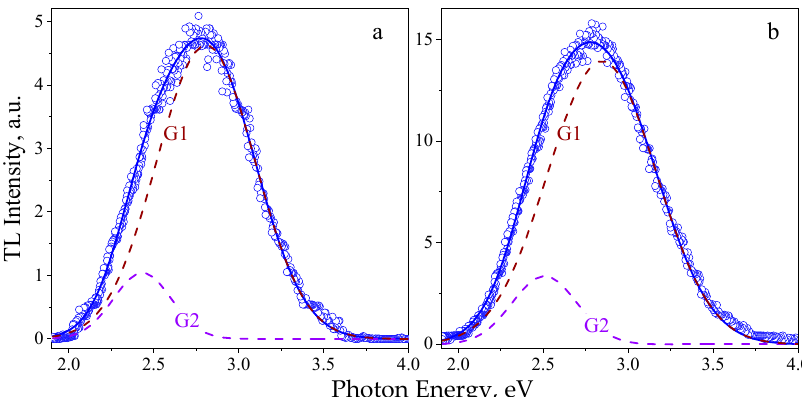
Figure 2. Emission spectra of natural TL in the Chelyabinsk chondrite ( a ) and induced TL in the Tsarev chondrite ( b ).